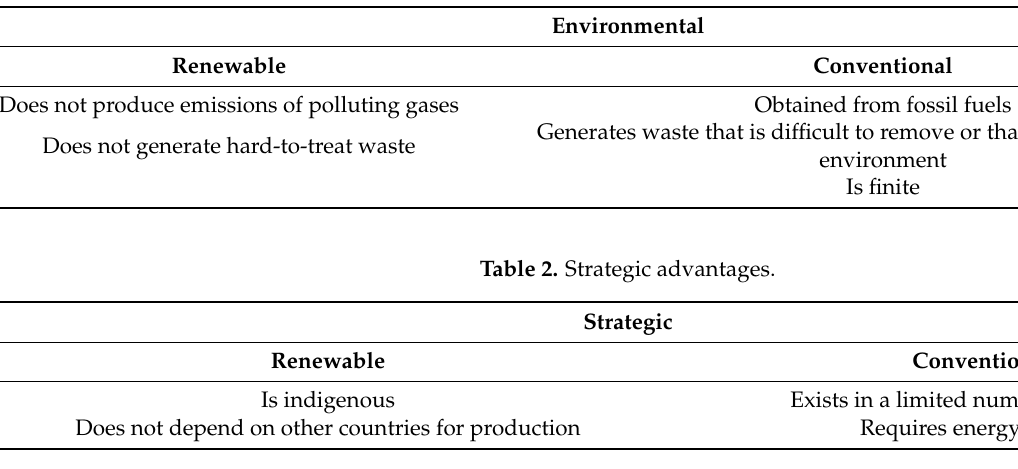
Table 1. Environmental benefits.